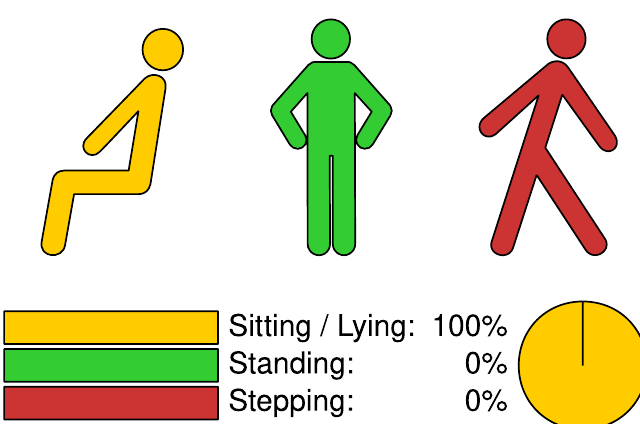
Figure 1. Automated accelerometric data recording of an immobile patient during early neurorehabilitation . An 81-year-old man suffering from polytrauma with severe traumatic brain injury six weeks prior to automated accelerometric recording over 24 h. Neurological status: Tetraparesis, tracheostomy due to severe dysphagia, cognitive deficits including lack of alertness and complete incontinence with a Barthel Index of 10 indicating complete dependency on staff and caregivers. No ability to independently turn or move. Automatic accelerometric recording does not distinguish position changes of this immobile patient during early neurorehabilitation.